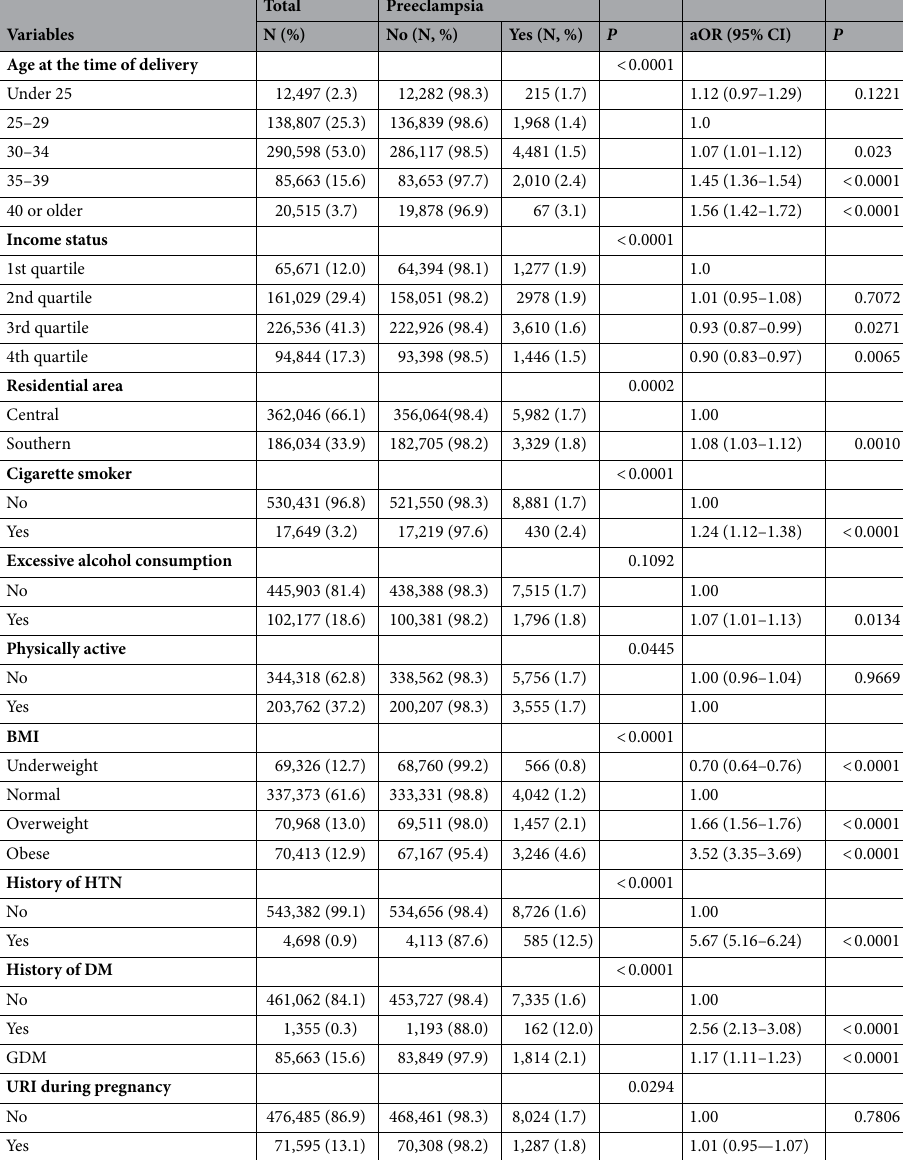
Table 1. Demographic data of the participants. BMI, body mass index; HTN, hypertension; GDM, gestational diabetes mellitus; URI, common